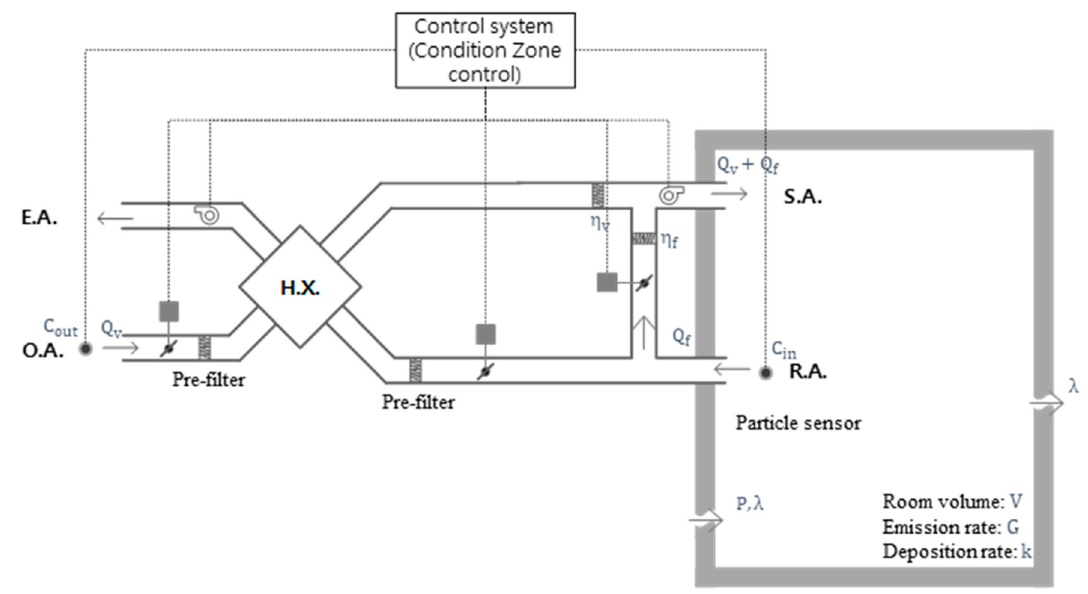
Figure 12. Schematic diagram of the ventilation and filtration system applied with the condition zone control system. Atmosphere 2020 , 11 , x FOR PEER REVIEW